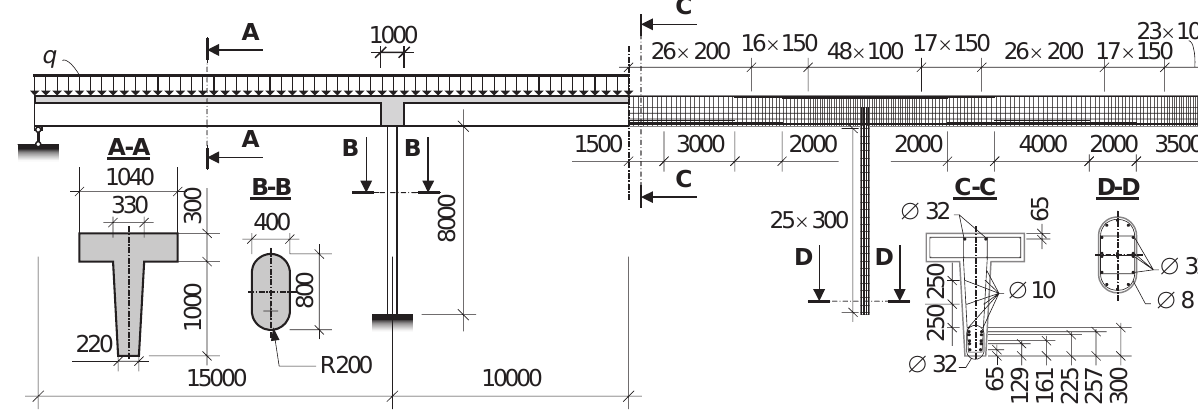
Fig. 5. Loading and reinforcing scheme of the modelled overpass